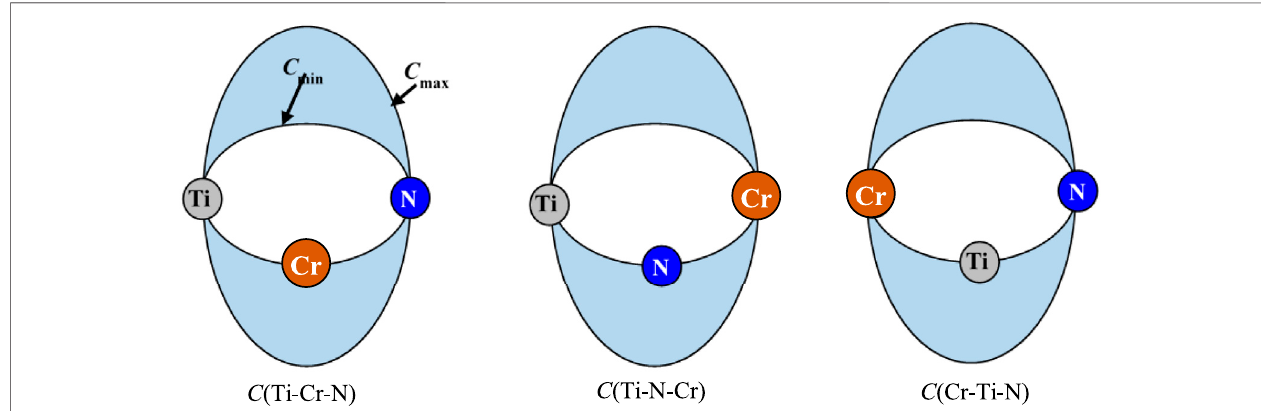
FIGURE 1 | Diagram of the three cases for the interactions screening between two neighboring atoms of various types by a third atom in the Ti – Cr – N ternary system.